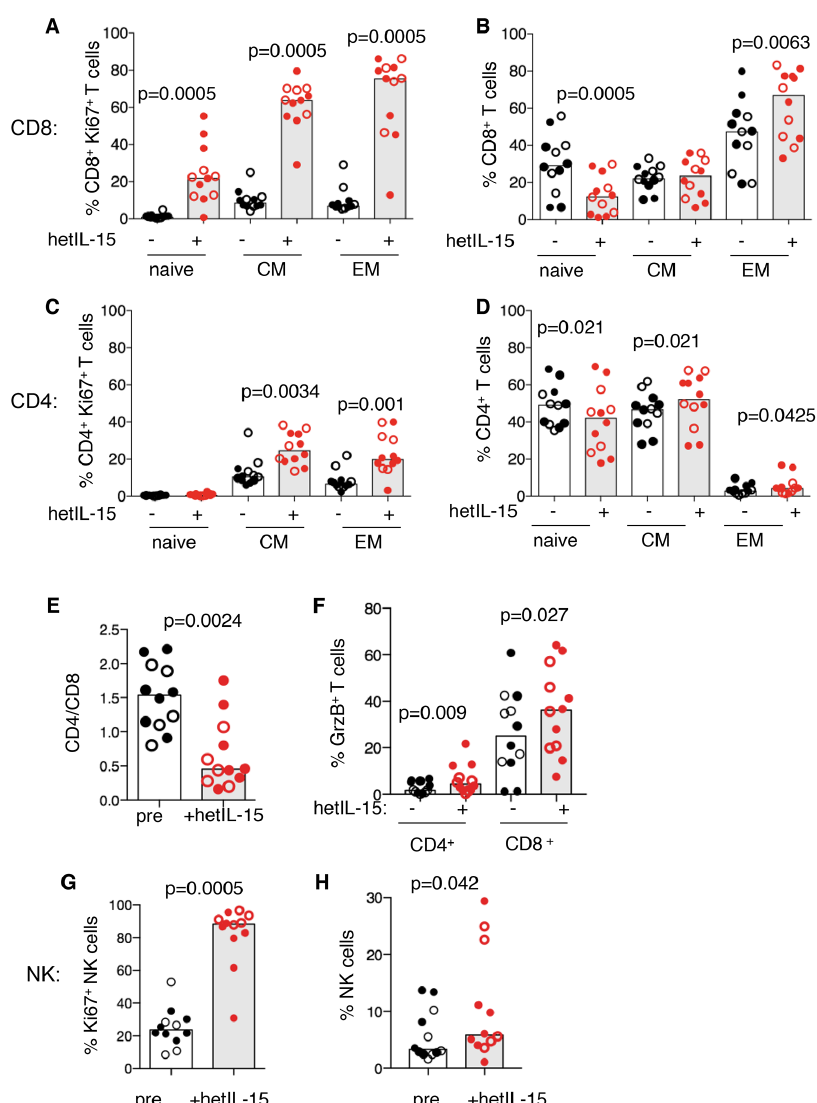
Fig 2. hetIL-15 effects in lymphocytes in peripheral blood. (A) Changes in lymphocyte populations were analyzed in blood samples collected from 12 macaques before (black symbols) and after hetIL-15 administration (red symbols). The animals included are indicated by (cid:3) in Fig 1C and represent 12 of the 16 animals shown in Fig 1. The effects of hetIL-15 treatment on (A) CD8 + Ki67 + T lymphocytes; (B) frequency of CD8 + subsets; (C) CD4 + Ki67 + T lymphocytes; (D) frequency of CD4 + subsets. (E) Effect of hetIL-15 on the blood CD4/CD8 ratio. (F) Effects of hetIL-15 on the granzyme B content of CD4 and CD8 cells in blood. (G-H) NK (CD3 - CD16 + GrzB -/+ ) cells were analyzed by measuring cycling status (Ki67 expression; G) and frequency (H). p values are from paired Wilcoxon signed rank test.